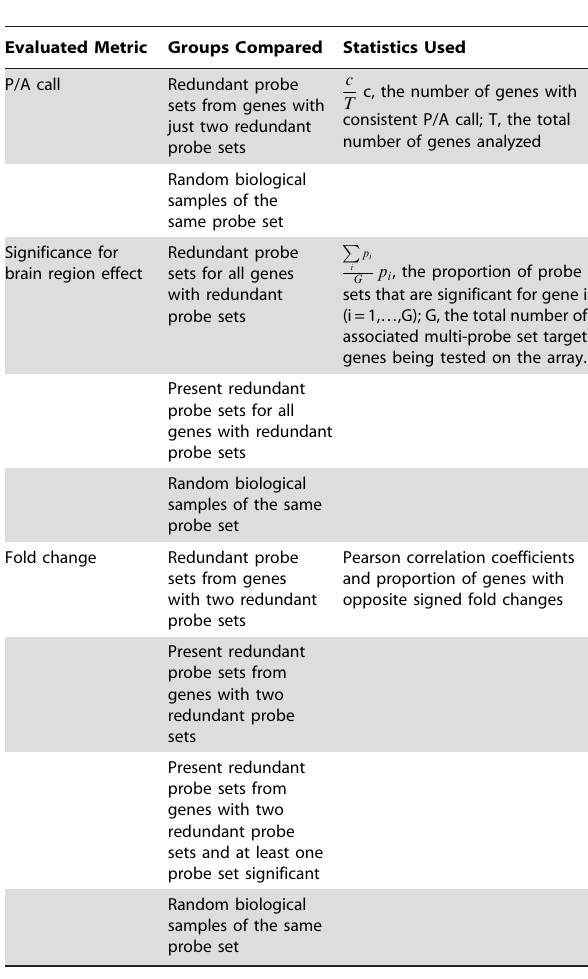
Table 5. Summary of redundant probe sets consistency